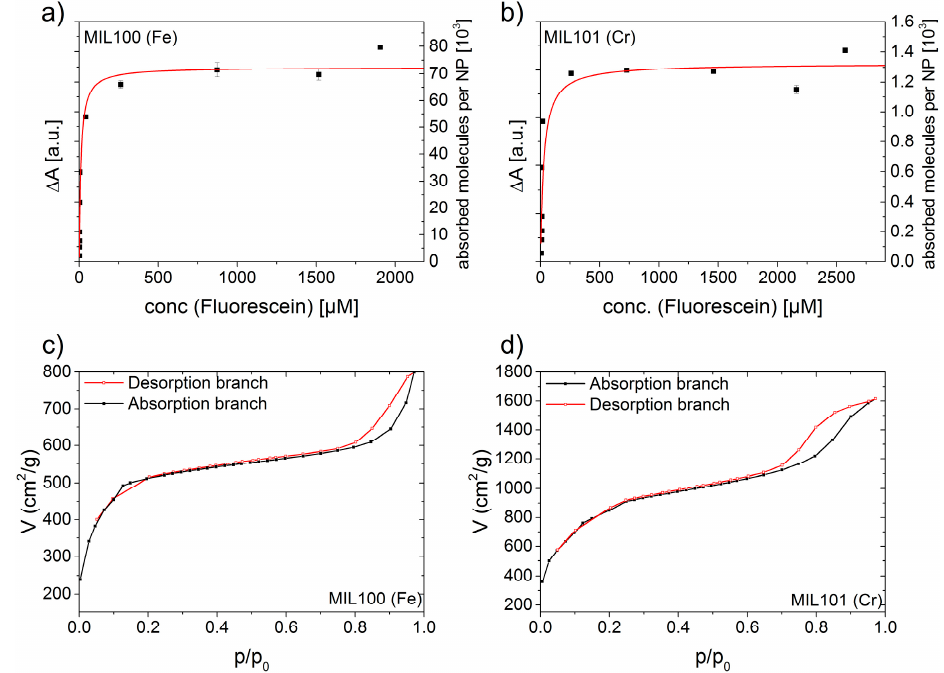
Figure 2. ( a , b ) Amounts of fluorescein loaded into MOF NP (obtained from the difference in absorption between the starting fluorescein solution and the supernatant recovered after loading) as a function of external fluorescein concentration fit to Langmuir-type curves. The calculated dissociation constants and maximum payload capacities per mg of NPs are: K MIL 100 = 11 µ M, K MIL 101 = 136 µ M, P MIL 100 max = 649.4 µ g, P MIL 101 max = 413.5 µ g ( c , d ) Measurements of nitrogen gas absorption by the MOF-NPs. The BET surface area obtained for MIL-100(Fe) NPs is 2004 m 2 /g and for MIL-101(Cr) is 3205 m 2 /g. Taking both into account yields a mean area occupied by one fluorescein molecule of 2 nm 2 for MIL-100(Fe) and 5 nm 2 for MIL-101(Cr).